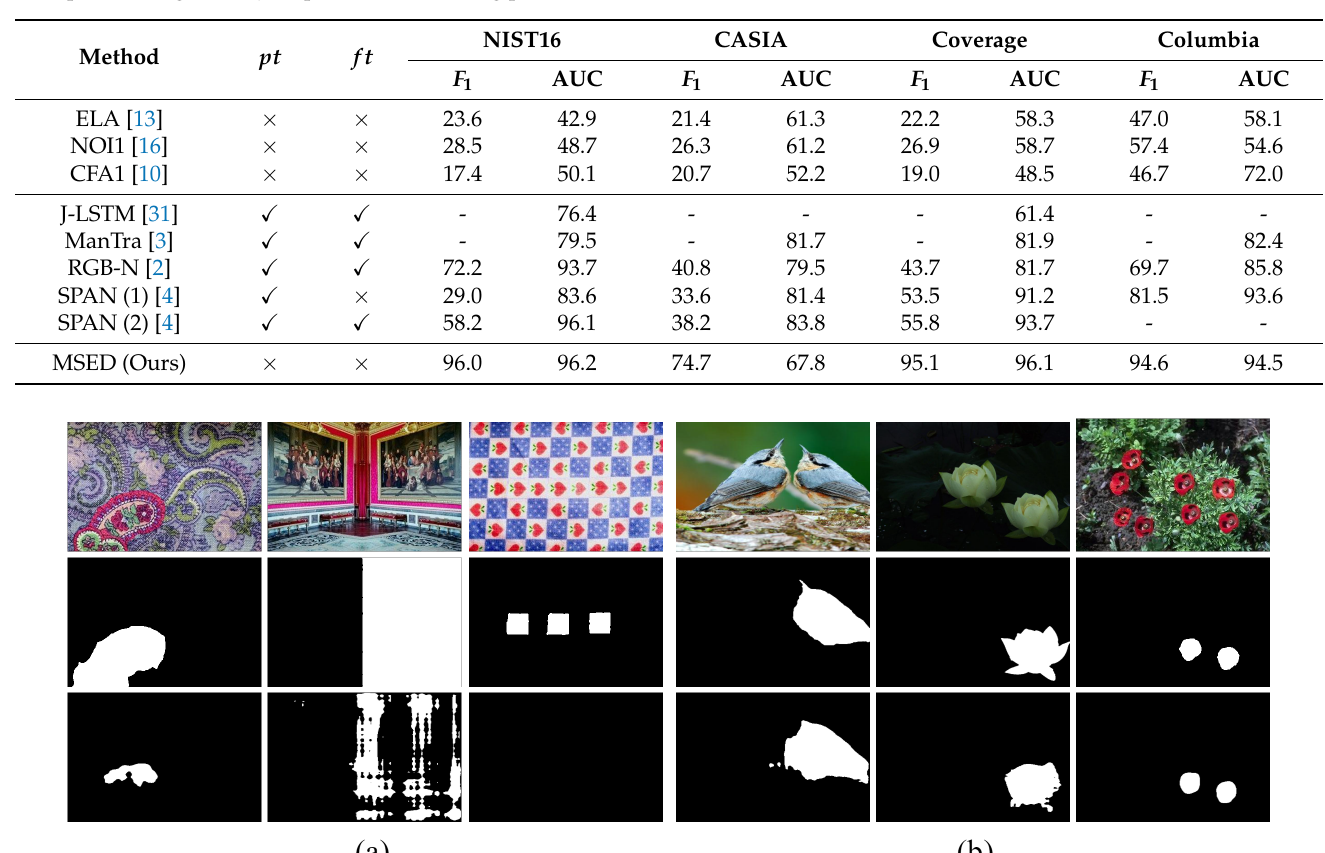
Figure 5. From the right side, we can see MSED is still very effective in comparison to the other copy-move manipulations. Table 1. F 1 score (%) and AUC (%) comparisons between our proposed method and baselines on benchmarks. pt donates pre-training, while ft represents fine-tuning process.